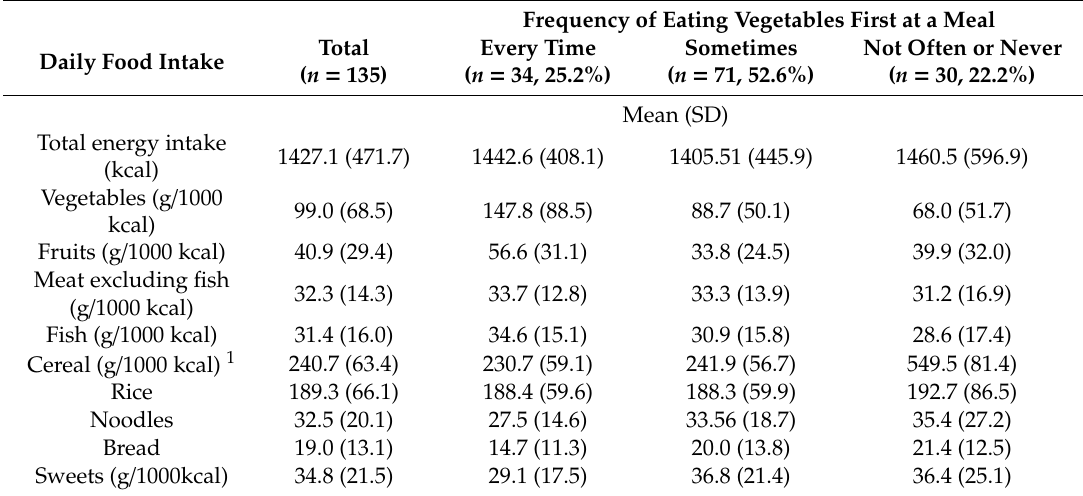
Table 2. Summary of major food group intakes by frequency of eating vegetables first at a